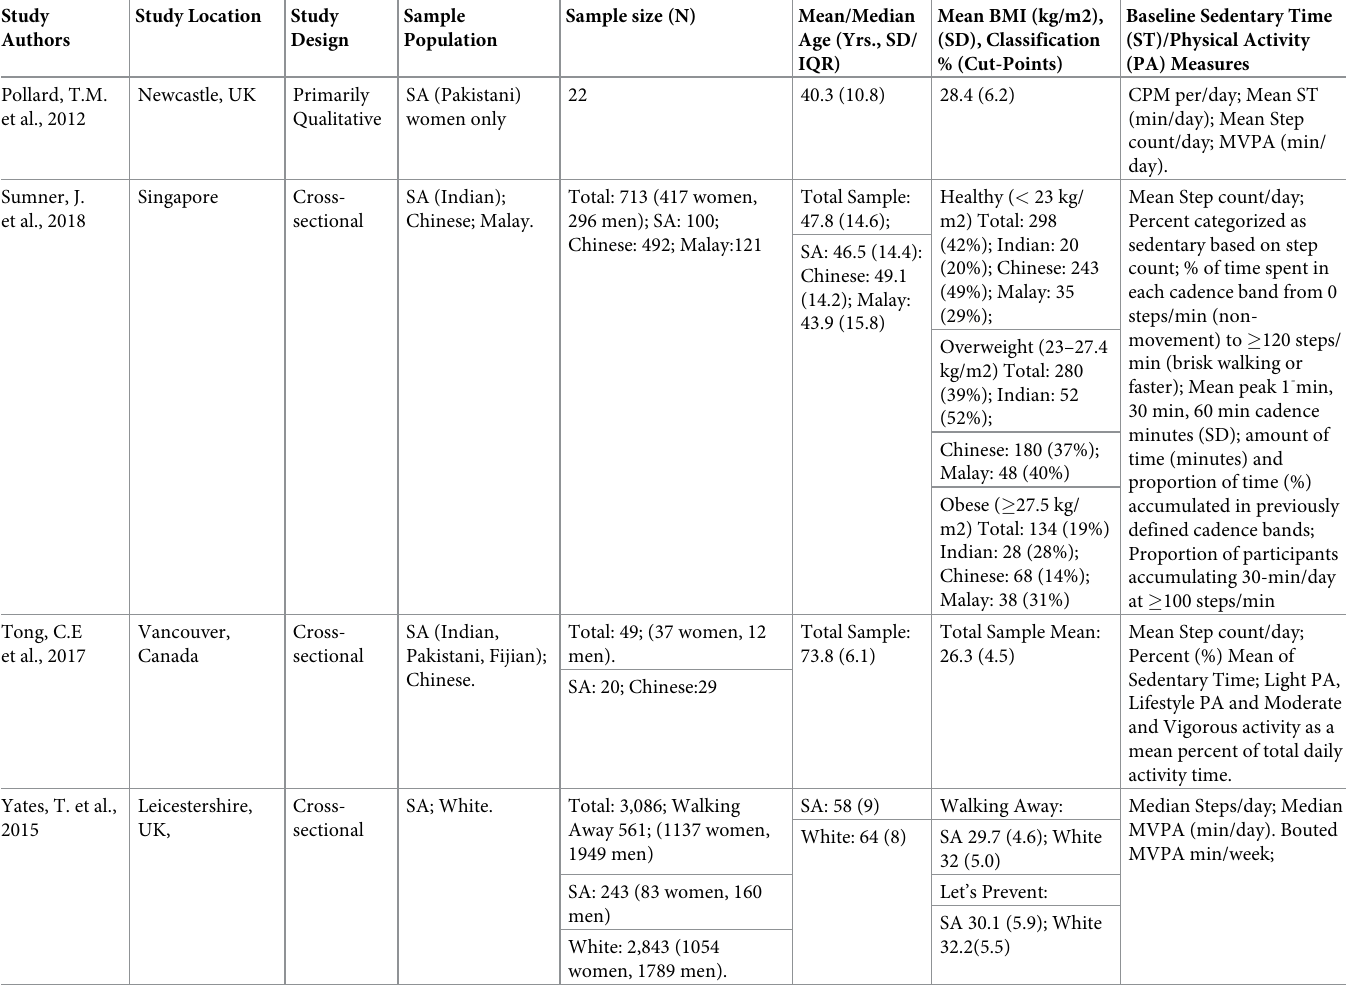
3.6.3 Moderate to Vigorous Physical Activity (MVPA). Mean min/day of MVPA for South Asian sample ranged from 16.7 min/day [48] to 57.9 (30.4) min/day [49] (Fig 3A) (Table 3). Mumu et al reported significant differences in the MVPA for rural versus urban partici- pants (51 min/day for rural and 69 min/day for the urban, p = 0.001). Illiodimitri et al., reported significantly higher median MVPA min/day for White, [45.3 (IQR 28.2, 70.7) min/ day], compared with South Asians [(23.8 (IQR 11.41, 42.5P = 0.0001. Castaneda-Gameros D. et al., observed lowest levels of MVPA in African Caribbean group [9.5 (11.0) min/day)], fol- lowed by South Asians [20.0 (21.4) min/day] and others [20.3 (18.2)]. These differences were not statistically significant though. Yates et al., also observed slightly higher median minutes per day of MVPA in White [21.5 (IQR 10.5, 41.6)], compared with South Asians [18.0 (7.5, 36.1)]. Once adjusted for age, sex, social deprivation and accelerometer wear time, these differ- ences were not significant [42]. Among women of various ethnic groups, Nicolaou et